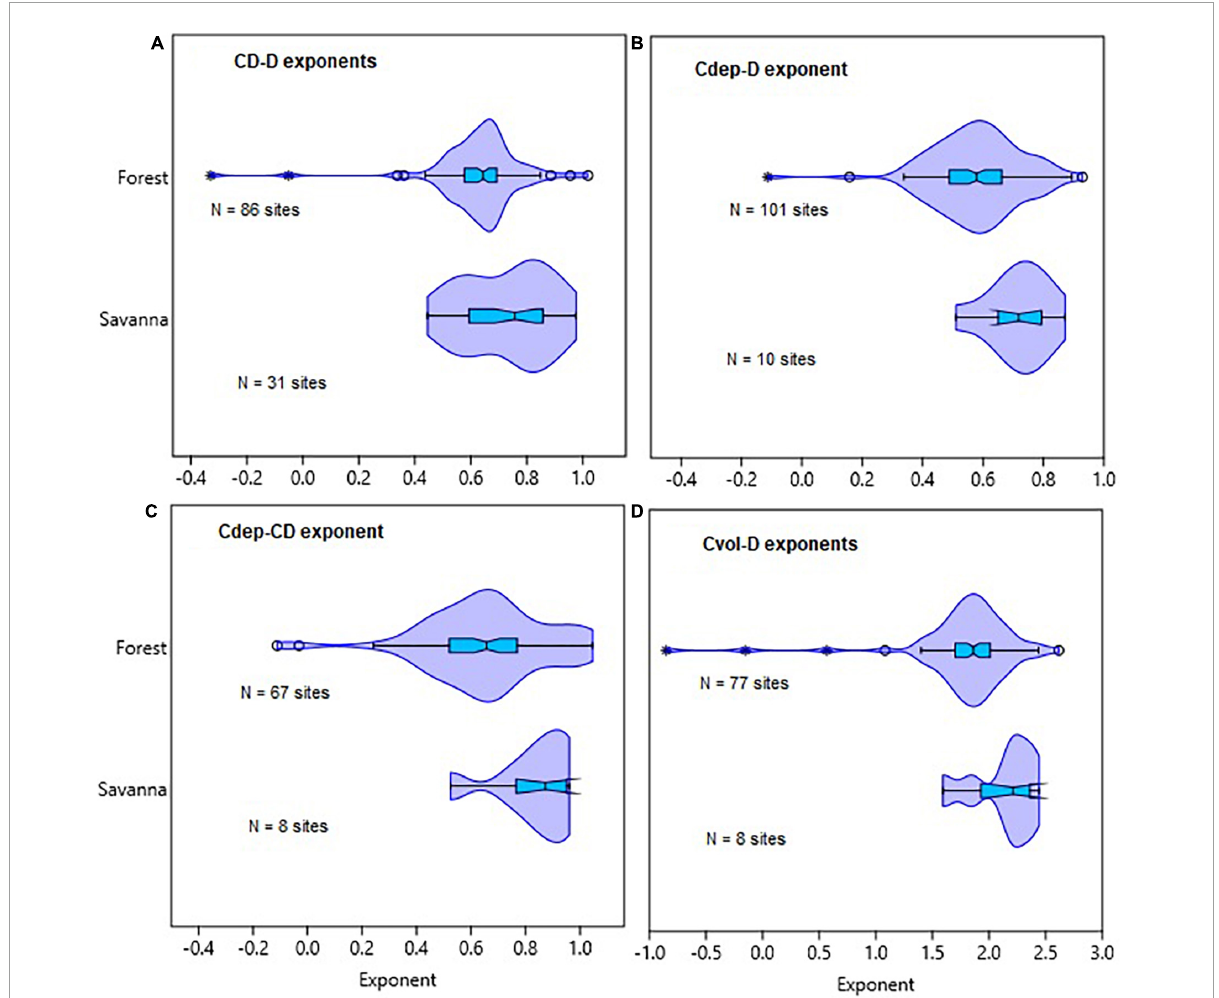
FIGURE3 Comparison of tropical forest and savanna biomes in terms of the distribution of allometric exponents of crown diameter with stem diameter (CD–D), crown depth with stem diameter (Cdep–D), crown depth with crown diameter (Cdep–CD), and crown volume with stem diameter (Cvol–D) scaling. The distributions of exponents for the different allometric relationships are given in (A–D) . The box and whisker plots display the median and its 95% CI (notches), lower quartile, upper quartile, extreme values and outliers (O and *).